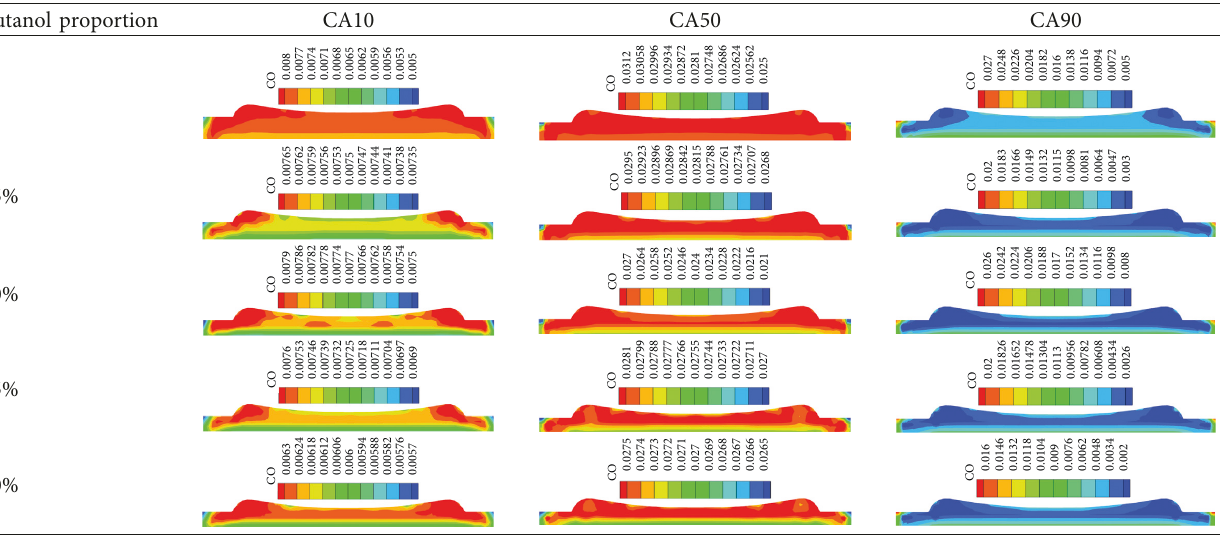
Table 4: The in-cylinder distribution of the carbon monoxide concentration.